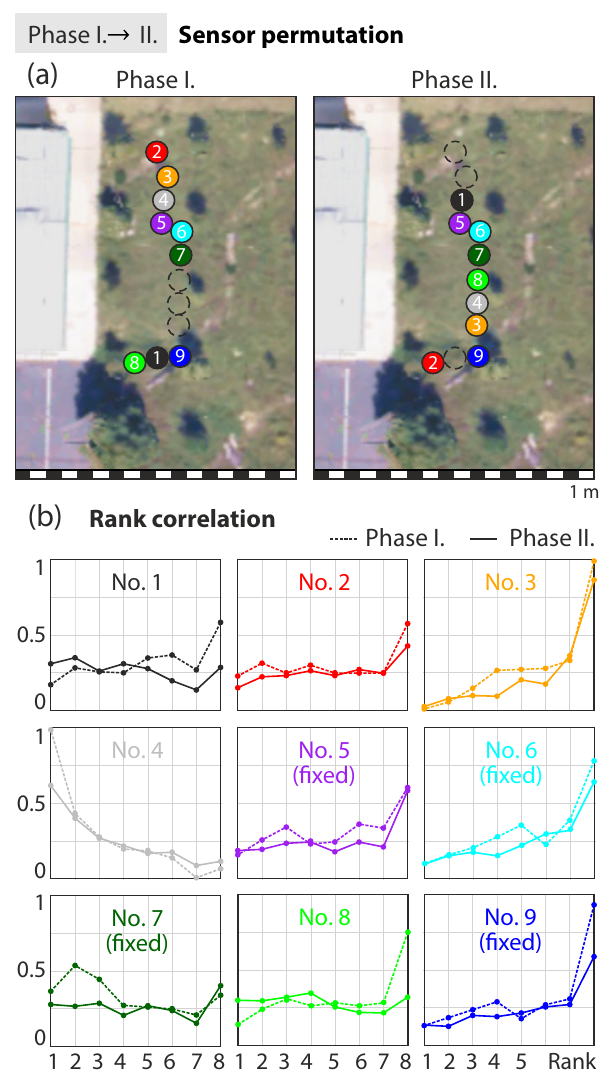
Figure 4. (a) Birds-eye view on the sensor arrangement before and after permutation of sensors 2, 3, 4, and 8. (b) Rank correlations of the nine CRNS signals before (dotted) and after (solid) permutation. Both swapped and fixed sensors showed no significant